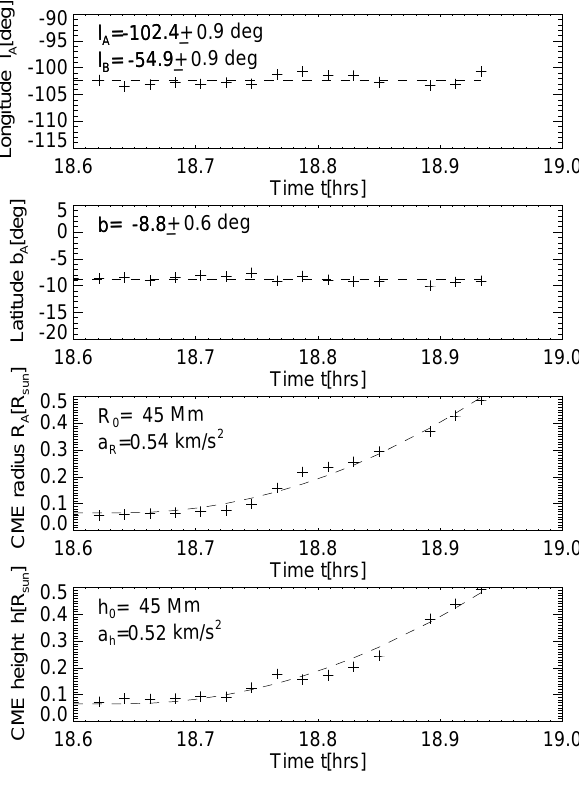
Fig. 4. Measurements of the heliographic longitude l A (t) (top panel) and latitude b(t) (second panel) of the CME centroid, the radius R(t) of the CME sphere (third panel), and CME centroid height h(t) (bottom). The average values are l A =− 102 . 4 ◦ ± 0 . 9 ◦ and b =− 8 . 8 ◦ ± 0 . 9 ◦ for the heliographic position. The CME radius R(t) and height h(t) are fitted with quadratic functions (dashed curves), yielding the constants t 0 = 18 . 64h (18:38UT), R 0 = 45Mm, h 0 = 45Mm, and accelerations a R = 0 . 54kms − 2 and a h = 0 . 52kms − 2 (see Eqs.